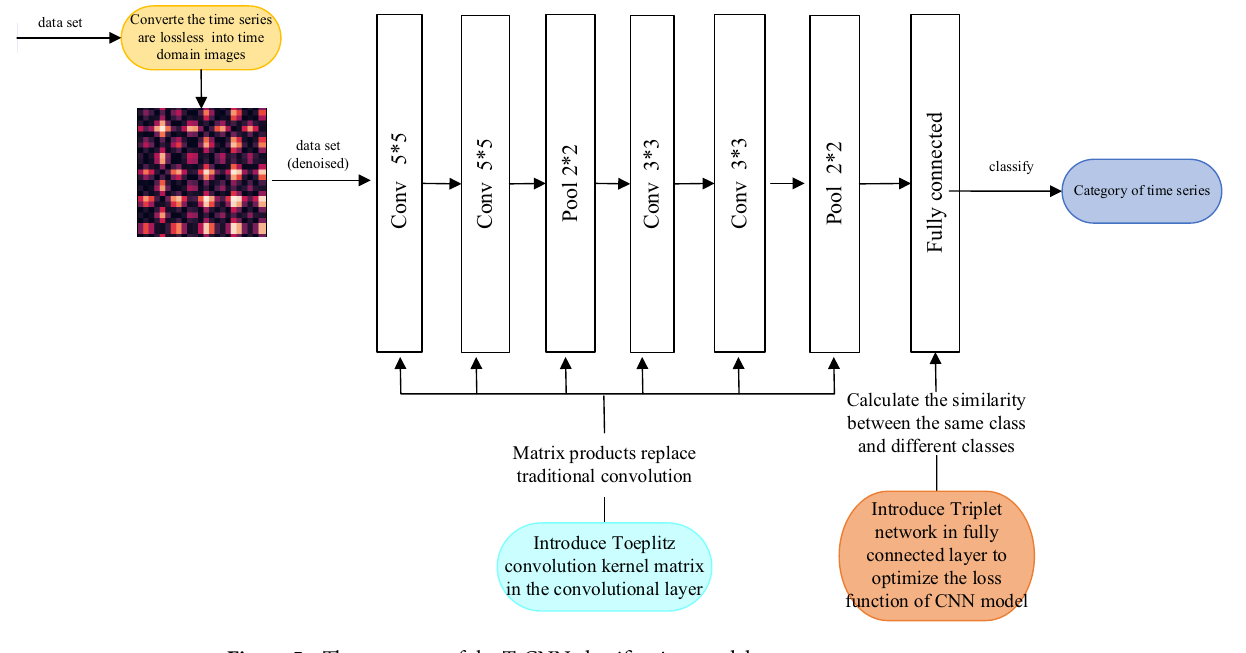
Figure 5. The structure of the T-CNN classification